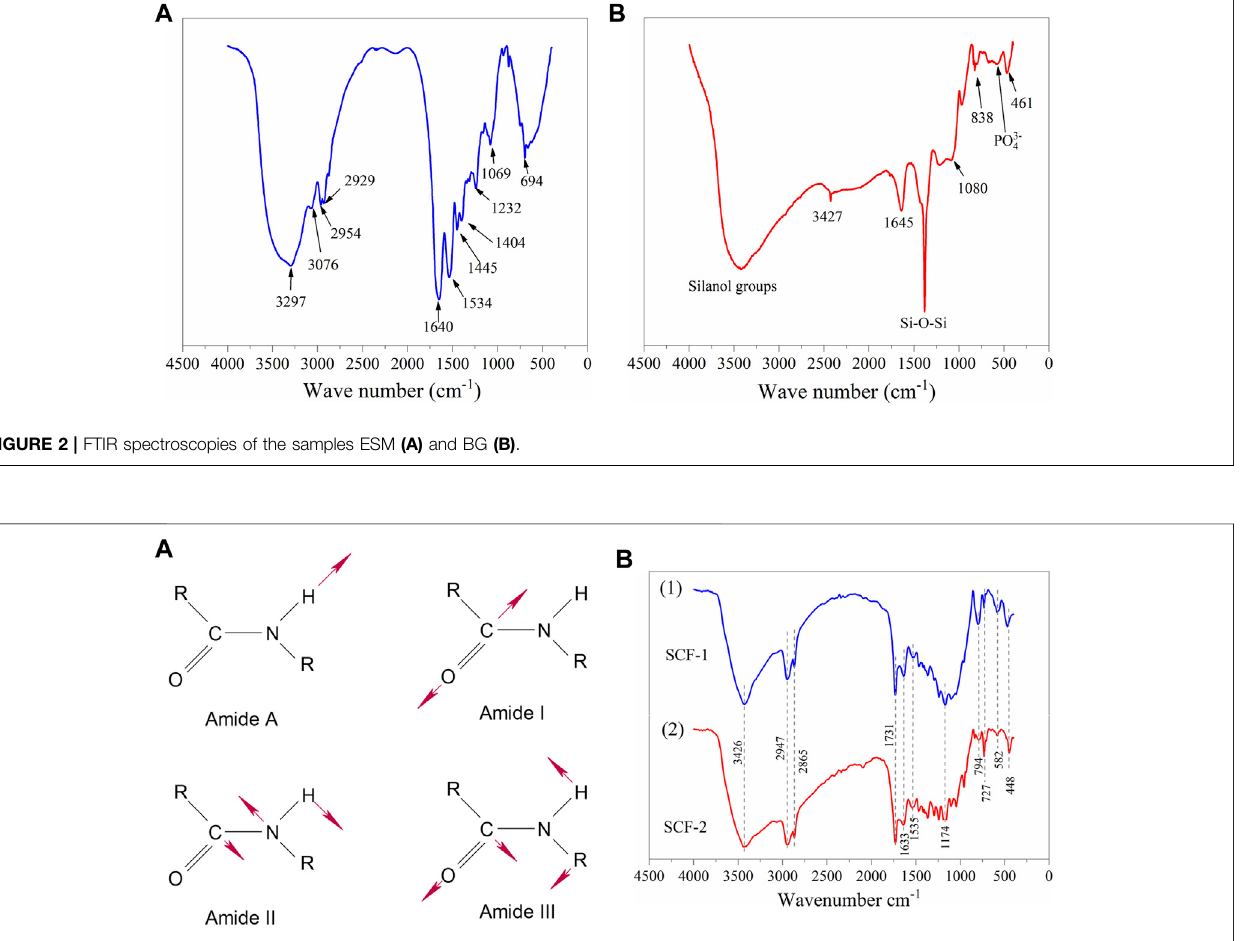
FIGURE 3 | Vibrational bands of amides (A) . FTIR spectra for the scaffolds SCF-1 and SCF-2 (B)